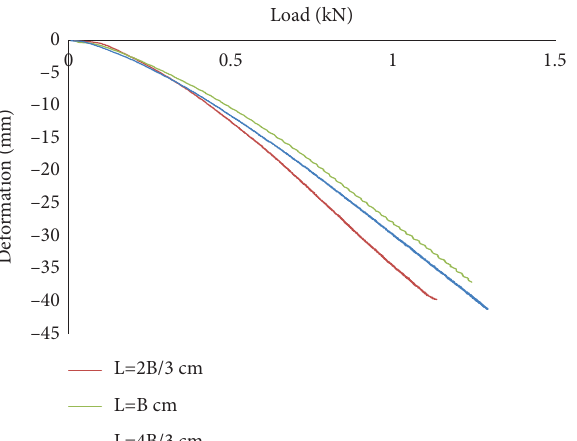
Figure 9: Load vs. foundation settlement in case of H